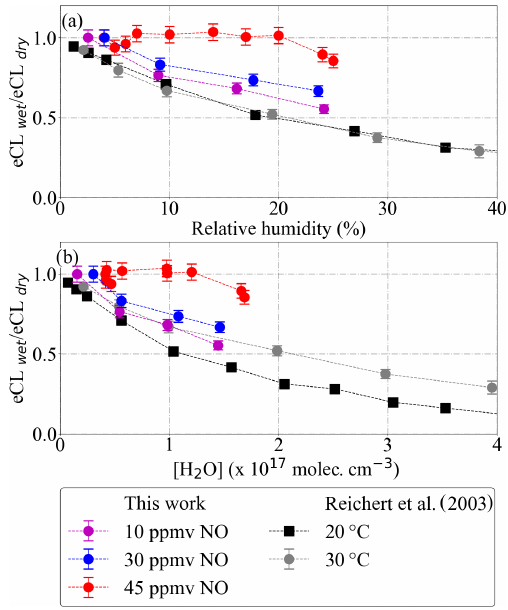
Figure 14. Dependency of PeRCEAS eCL (a) on inlet humidity and (b) on [H 2 O], at constant sampling flow, inlet pressure, (cid:49)P , [CO] and [N 2 ], measured at 300mbar and for 10ppmv (magenta), 30ppmv (blue) and 45ppmv (red) NO (respectively, 7 . 29 × 10 13 , 2 . 19 × 10 14 and 3 . 28 × 10 14 molec.cm − 3 [NO]). The values from Reichert et al. (2003) obtained for 3.3ppmv NO at 1atm (8 . 12 × 10 13 molec.cm − 3 [NO]) are also plotted for